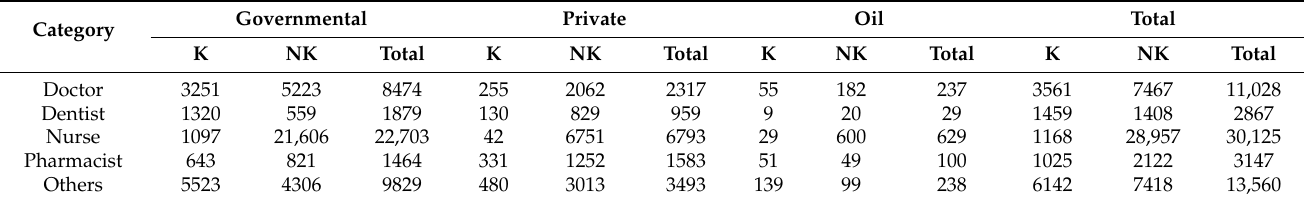
Table 2. Distribution of healthcare personnel according to the category and type of establishment, Kuwait 2017 [37].